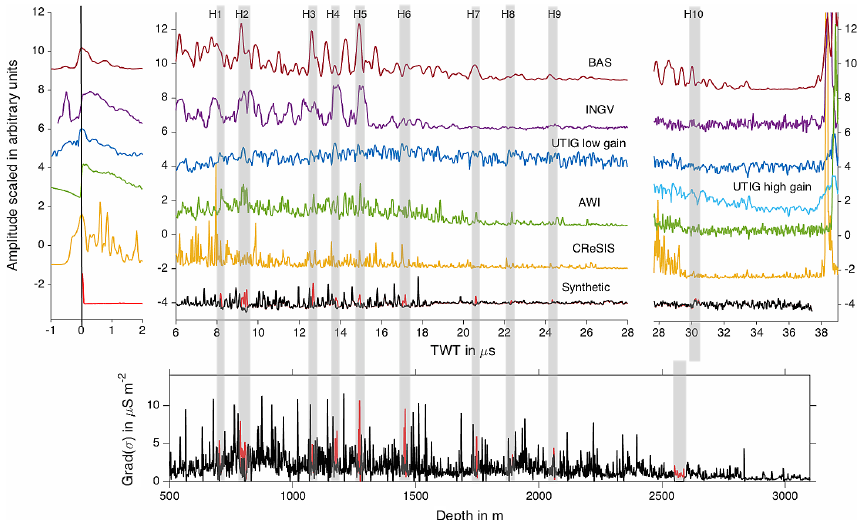
Figure 2. A-scopes for traces of the five radar systems (positions indicated by crosses in Fig. 1) and synthetic trace. The amplitudes are scaled individually and the exponential trend is removed. The surface reflection of each trace is shifted to time zero (left panel). Some distinct reflections that can be seen in some or all of the traces are gray shaded. The bottom panel shows the envelope of the gradient of the conductivity profile. The peaks that are plotted in red cause the identified reflections H1–H10 in the synthetic